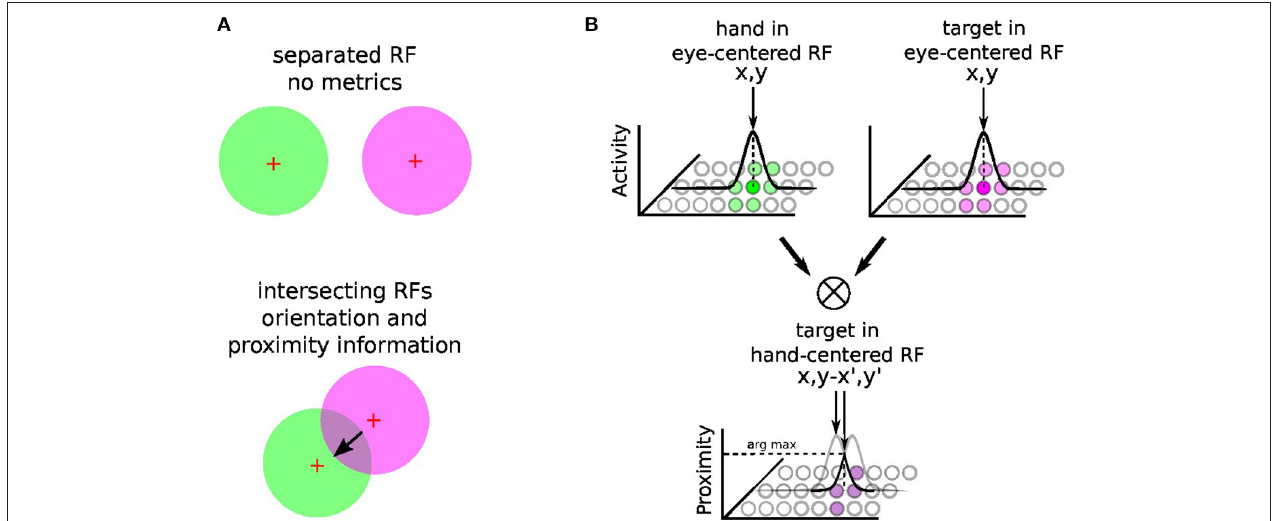
FIGURE 3 | Gain-field mechanism for spatial transformation and hand-centered representation. The mechanism of gain-field modulation discovered in parietal neurons corresponds to a multiplicative interaction across signals of different modalities (e.g., visual, tactile, auditive, or proprioceptive). Gain-field neurons see their amplitude level to vary with respect to targets motion relative to different reference frames, which can be arm-, head-, hand- or eye-centered. The multiplicative property between two receptive fields can permit the spatial transformation from one reference frame to another with a resulting receptive field whose amplitude and orientation relates directly to it; see (A) . For reaching one target, GF neurons may construct one arm-centered receptives fields to represent the distance and orientation to the target, presumably from the multiplication between hand and targets seen visually in the eye-centered RF; see (B) . Hypothesis reproduced from Ustun (2016) and Chang and Snyder